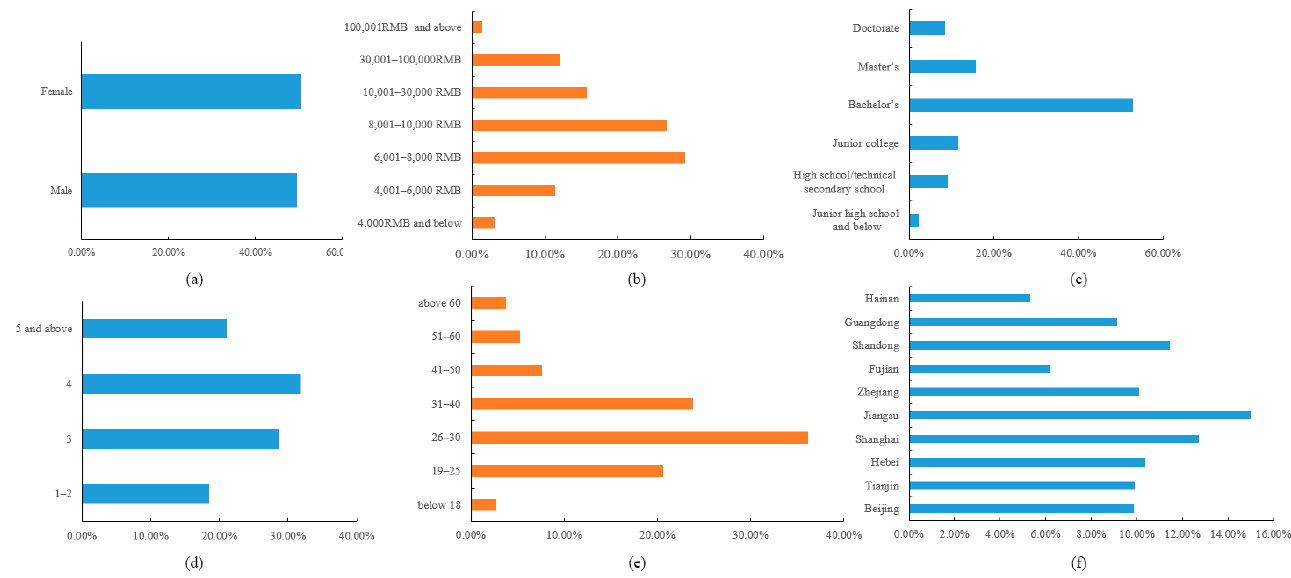
Figure 1. Demographic characteristics of the sample (N = 3257): ( a ) gender, ( b ) monthly income, ( c ) educational level, ( d ) family member, ( e ) age, and ( f ) province.